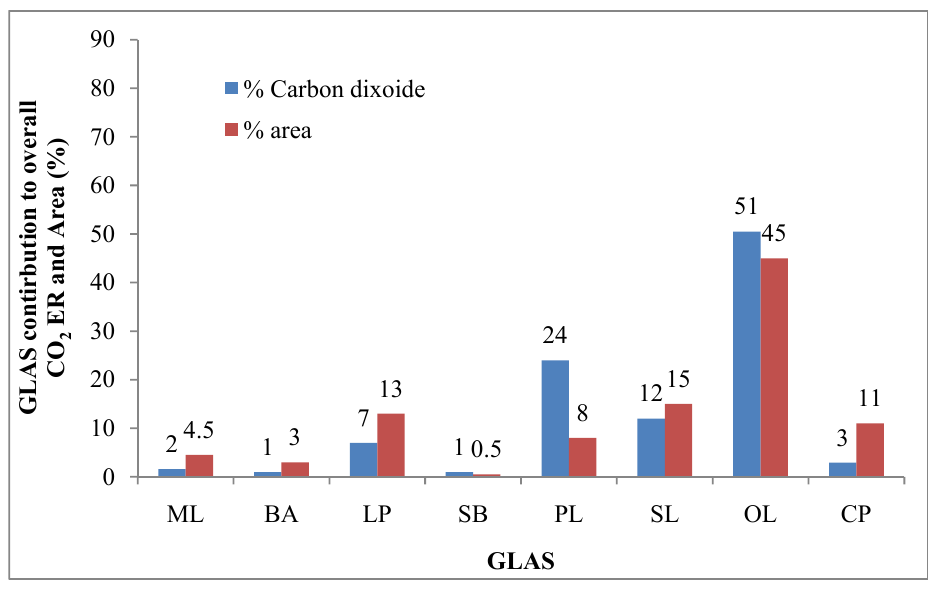
Figure 6. GLAS contribution to overall CO ERs and area at Free-stall dairy during the 2 summer. (Note: ML = manure lane; BA = bedding area; LP = loafing pen; SB = settling basin; PL = primary lagoon; SL = secondary lagoon; OL = open-lot; and CP = compost